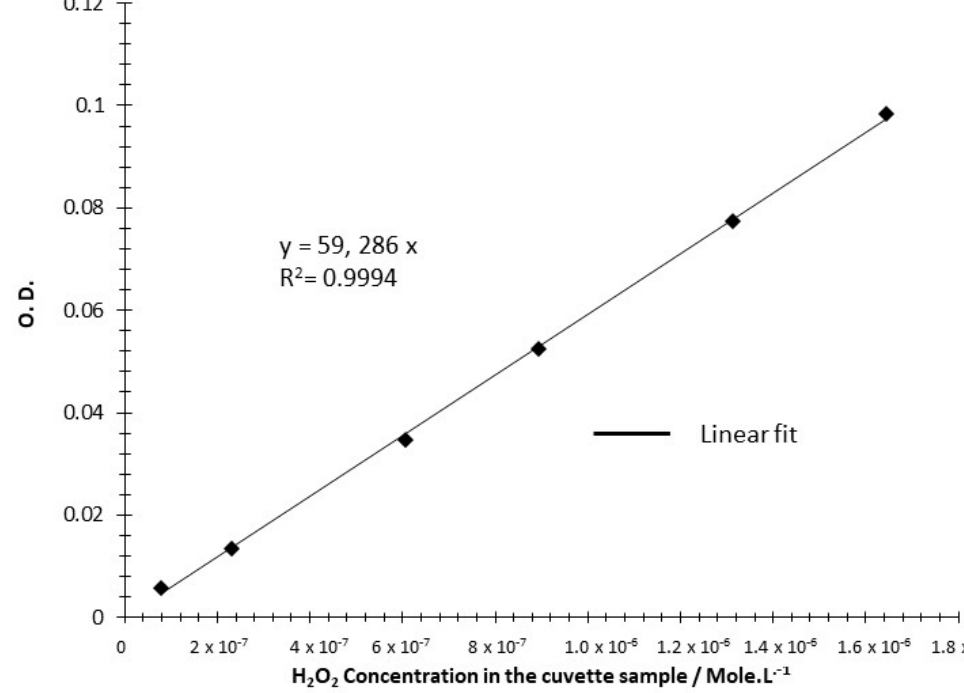
Figure A4. Calibration curve established by spectrophotometry using solution of H 2 O 2 of known concentration in HCLO 4 0.1 M (see reference [18] and Section 2.3 of the paper for details). The selectivity and H 2 O 2 % were measured at three different times of the chronoamperometry recorded at 600 mV vs. SHE. The data show the quite low variation observed between the different Table A1. Data showing the three selectivity measurements and related H 2 O 2 % deduced from H 2 O 2 assaying in the electrolyte after 10, 20 and 30 min of the ORR chronoamperometry at 600 mV vs SHE (see Figure 7 of the paper). The data concern the six catalysts studied in this work. From these data at 10, 20 and 30 min averaged selectivity and H 2 O 2 % is calculated for each catalyst (see Table 5 of the paper).